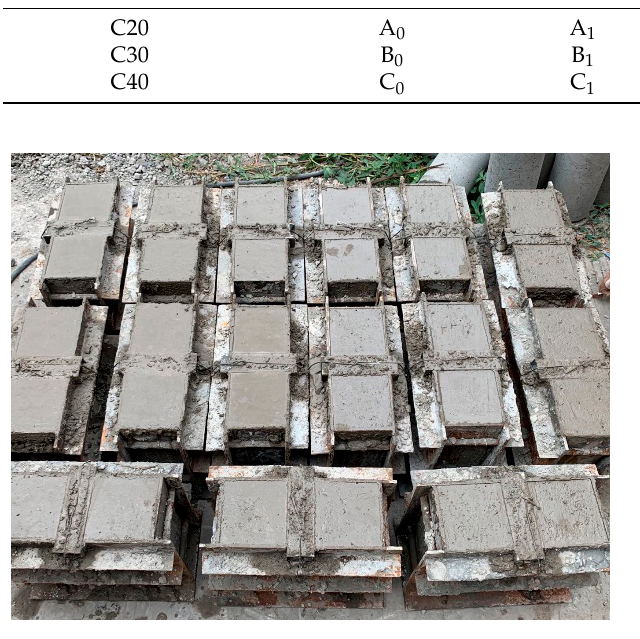
Figure 2. Concrete specimens were prepared.